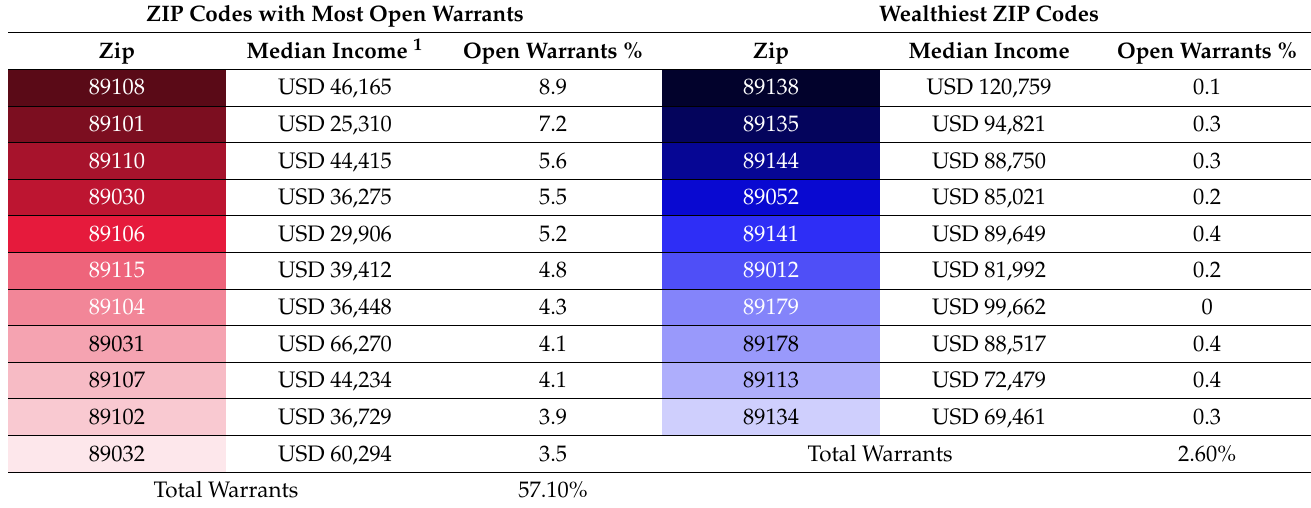
Table 3. Figure 3 Key—Open Warrants by ZIP Codes in Clark County, Nevada (City of Las Vegas Median Household Income USD 56,354).